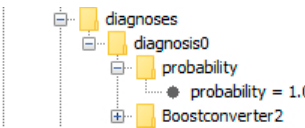
Figure 22. The diagnosis corresponding to the malfunction of Boostconverter2. The diagnosis consists only of Boostconverter2, meaning that a malfunction of Boostconverter2 would explain the observed discrepancy.